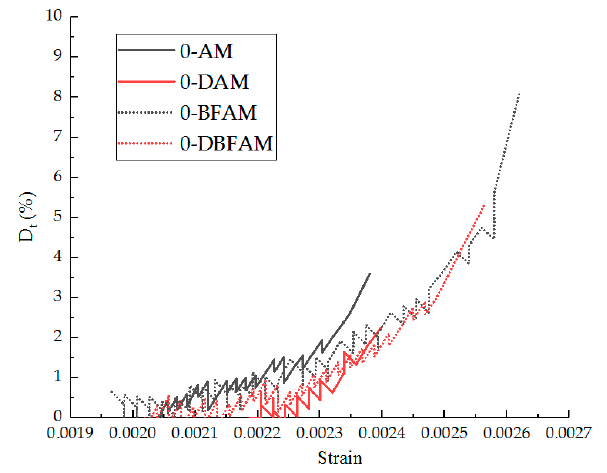
Figure 18. D t values in the nonlinear zone before F–T cycles.